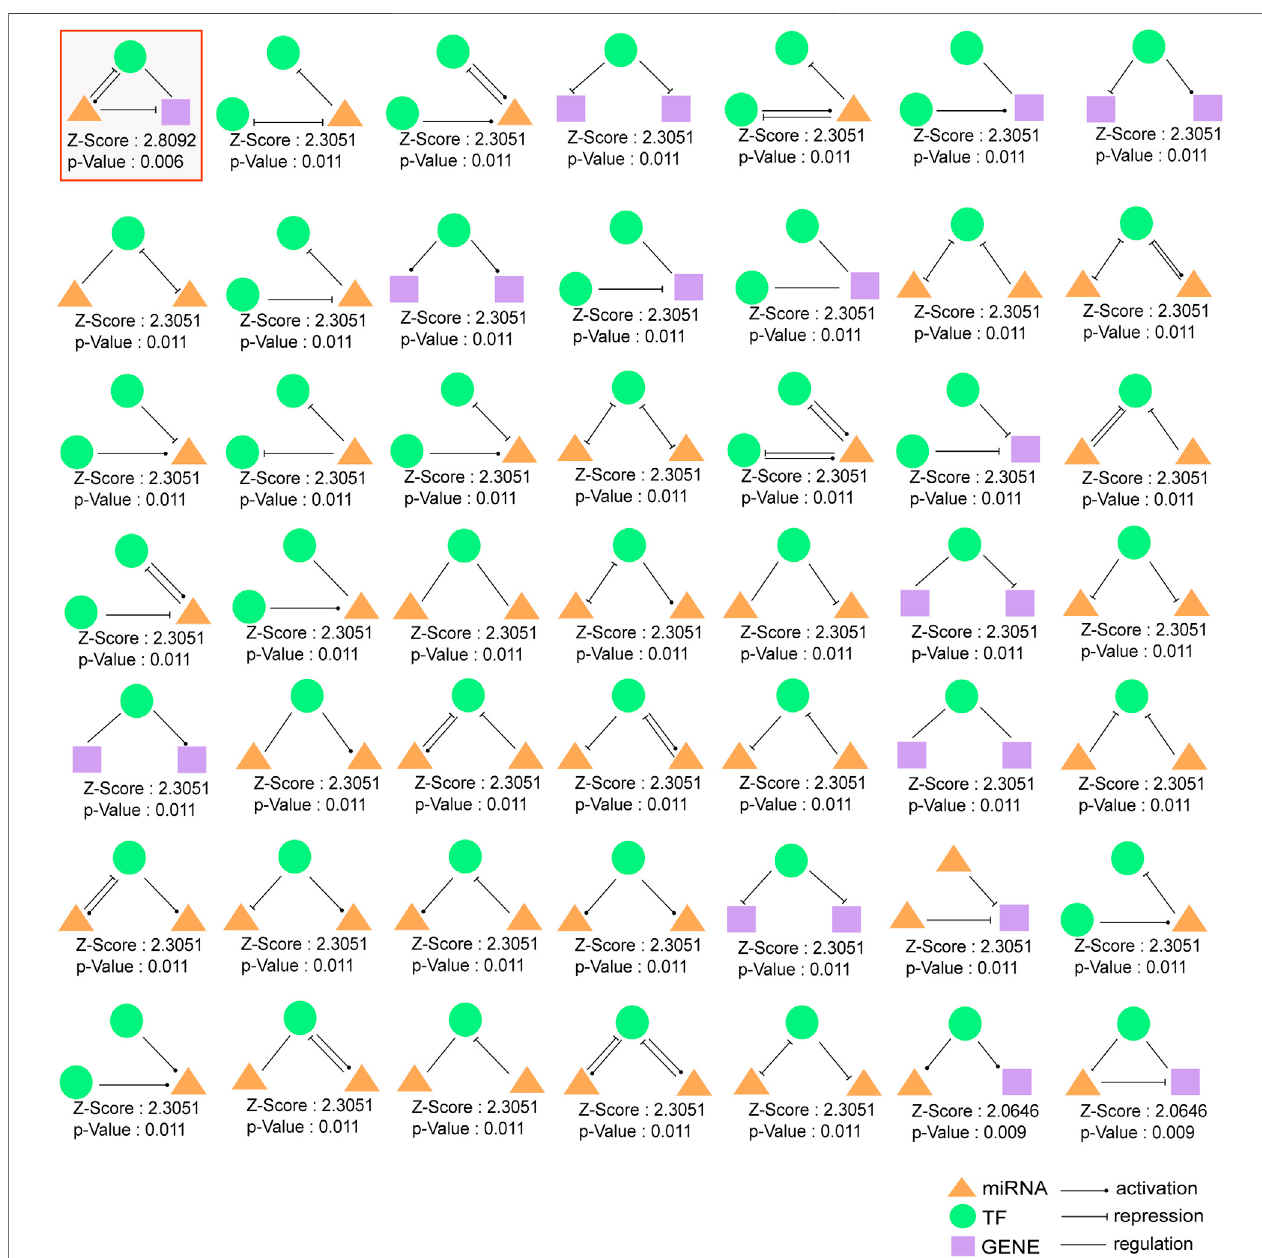
FIGURE 4 | 49 different types of 3-node regulatory motifs. The motifs are composed of miRNAs, TFs, and immune genes and their Z-scores and p -values are presented. Orange triangle represents miRNA, green round represents transcription factor (TF) and purple square represents immune gene. An arrow ending in a circle represents the activation relationship, an arrow ending in a “ T ” represents the repression relationship, while, a straight line without an arrow represents regulatory relationship. Motif surrounded by red squares (3-node composite feed-forward loop (FFL)), regarded as signi fi cant motif, and was merged to form 3-node regulatory